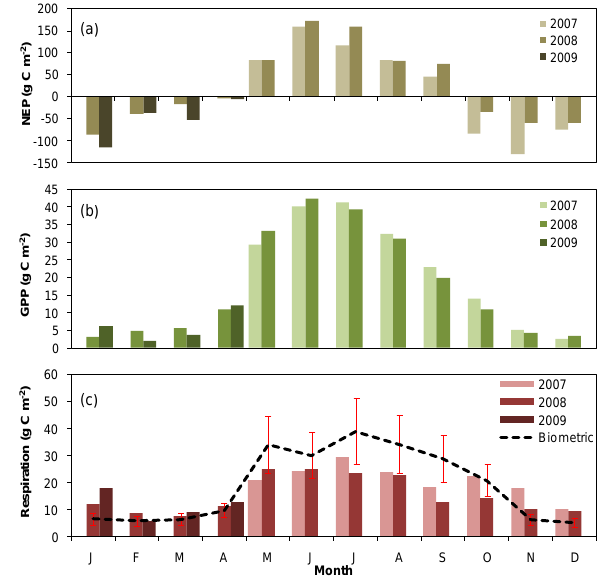
Fig. 7. Monthly total NEP (a) and partitioned monthly totals for (b) GPP and (c) respiration. For R e monthly total biometric/chamber estimates of ecosystem respiration during 2008 (Fenn et al., 2011) with error bars have been overlaid for